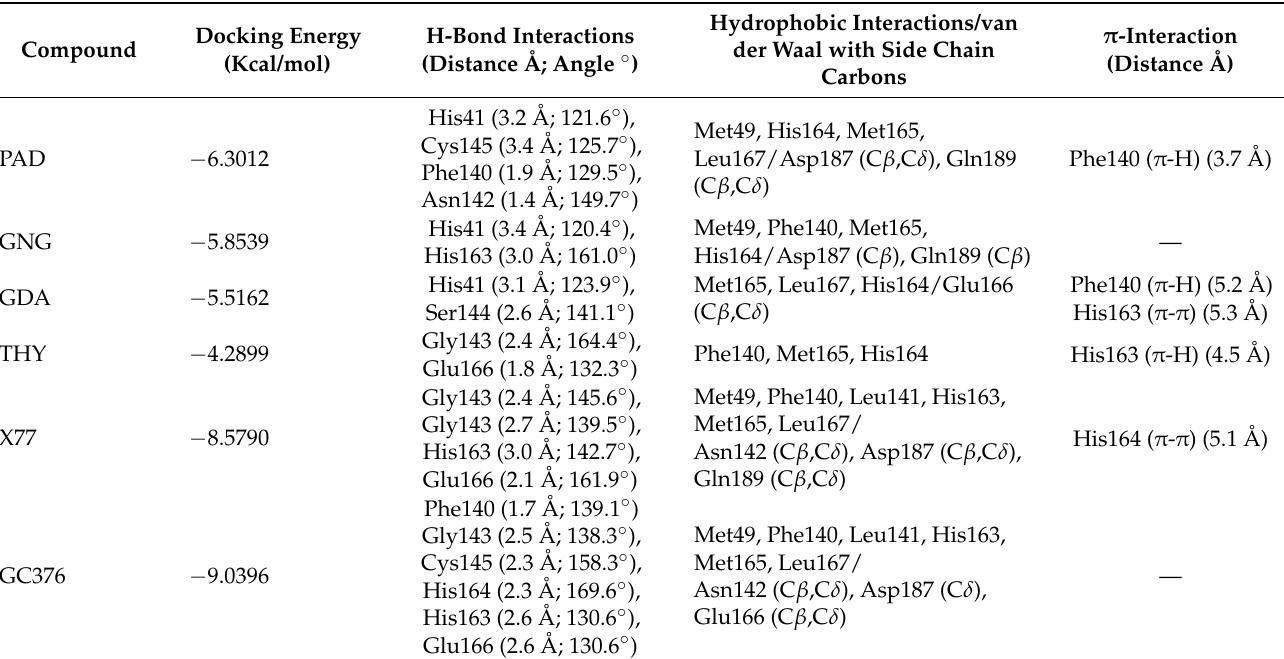
Table 4. Ligand-target binding interaction parameters for the docked ligands and positive controls within M PRO binding